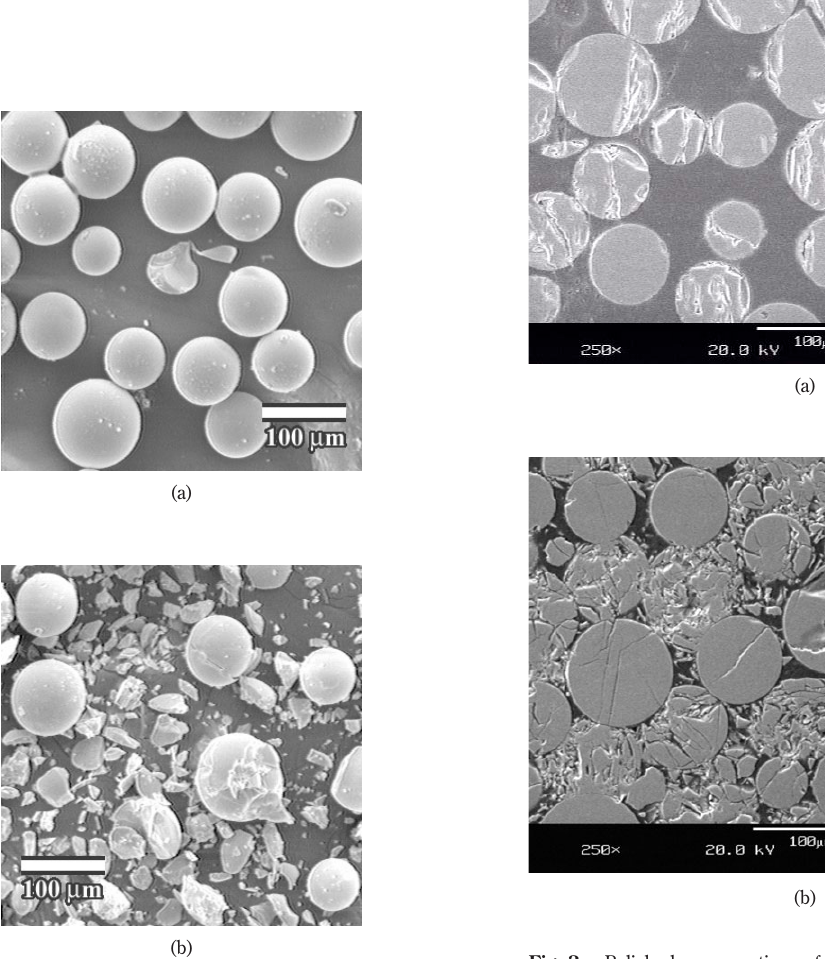
Fig. 3 Polished cross sections of glass beads mounted in epoxy: (a) compaction pressure 170 MPa, relative density 64%,